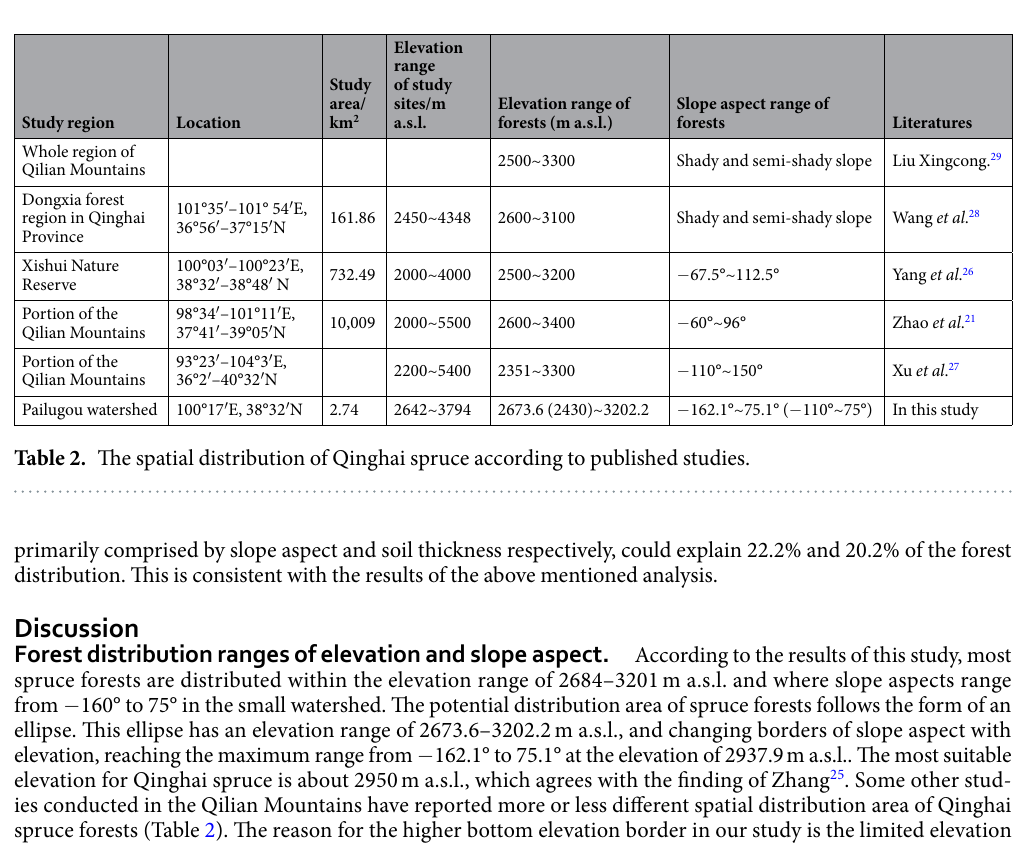
Figure 9. Slope gradient composition of all vegetated units within the potential distribution area of Qinghai spruce forests. This map was generated using Microsoft Excel 2010 software.